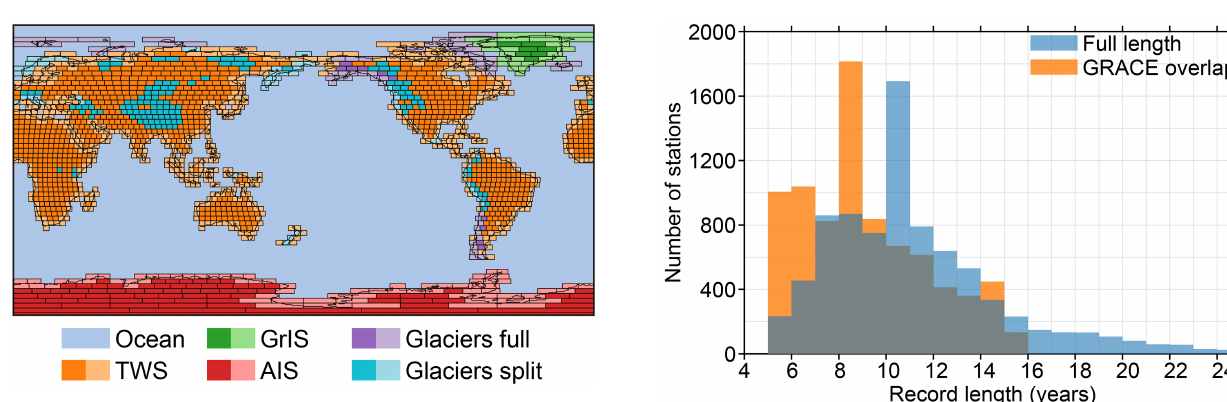
Figure 5. Histogram of the record length per station. Shown are all stations that fit the criteria outlined in Sect. 2.4. The blue bars show the record length before removing data outside the GRACE time span, and orange bars show the record length after removing